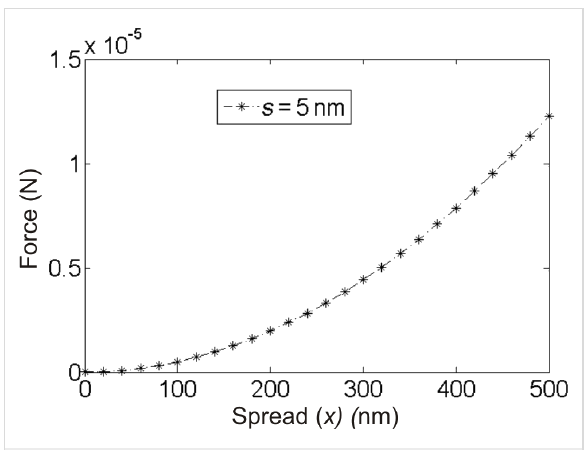
Figure 4: Force-vs-distance ( x ) curve according to Equation 3 plotted for s = 5